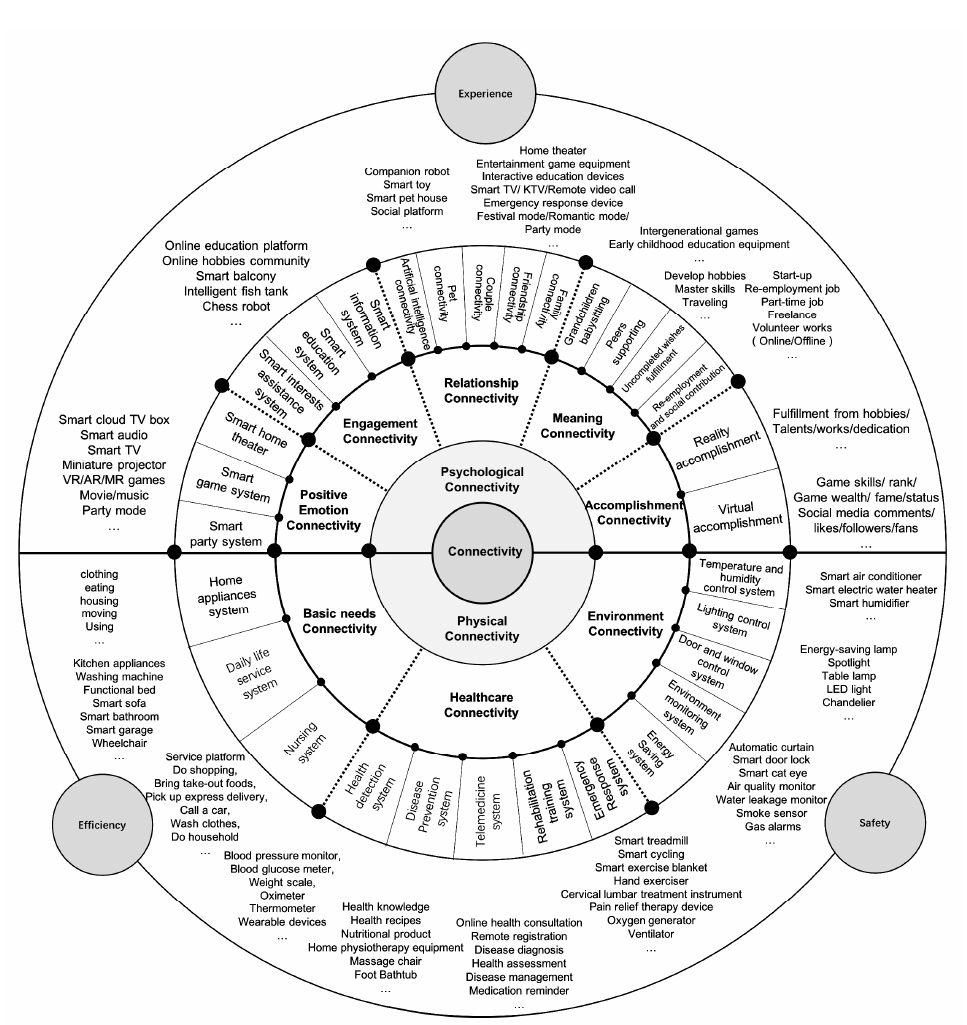
Figure 2. The connectivity system of a smart home for new elders.